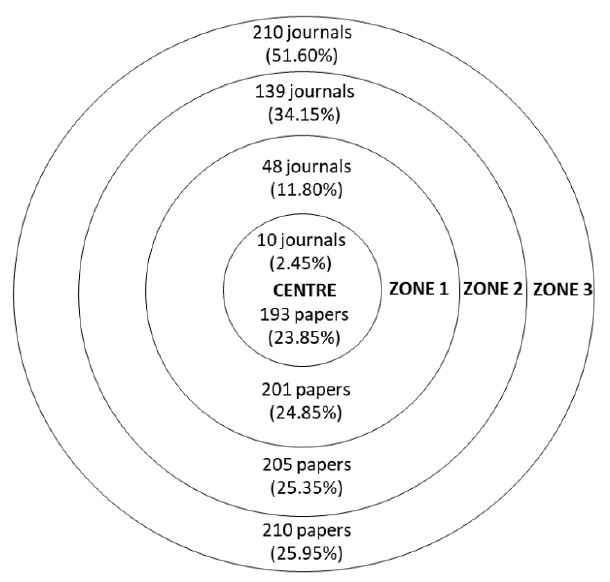
Figure 3. Bradford’s scattering zones of scientific journals on OUs.